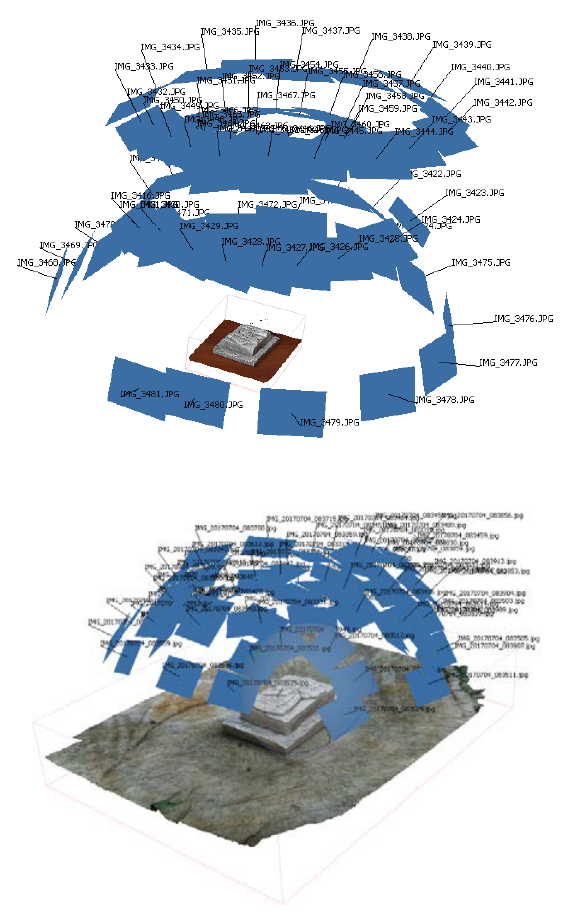
Figure 2. Position and orientation of the captured images in case of camera (up) and mobile phone